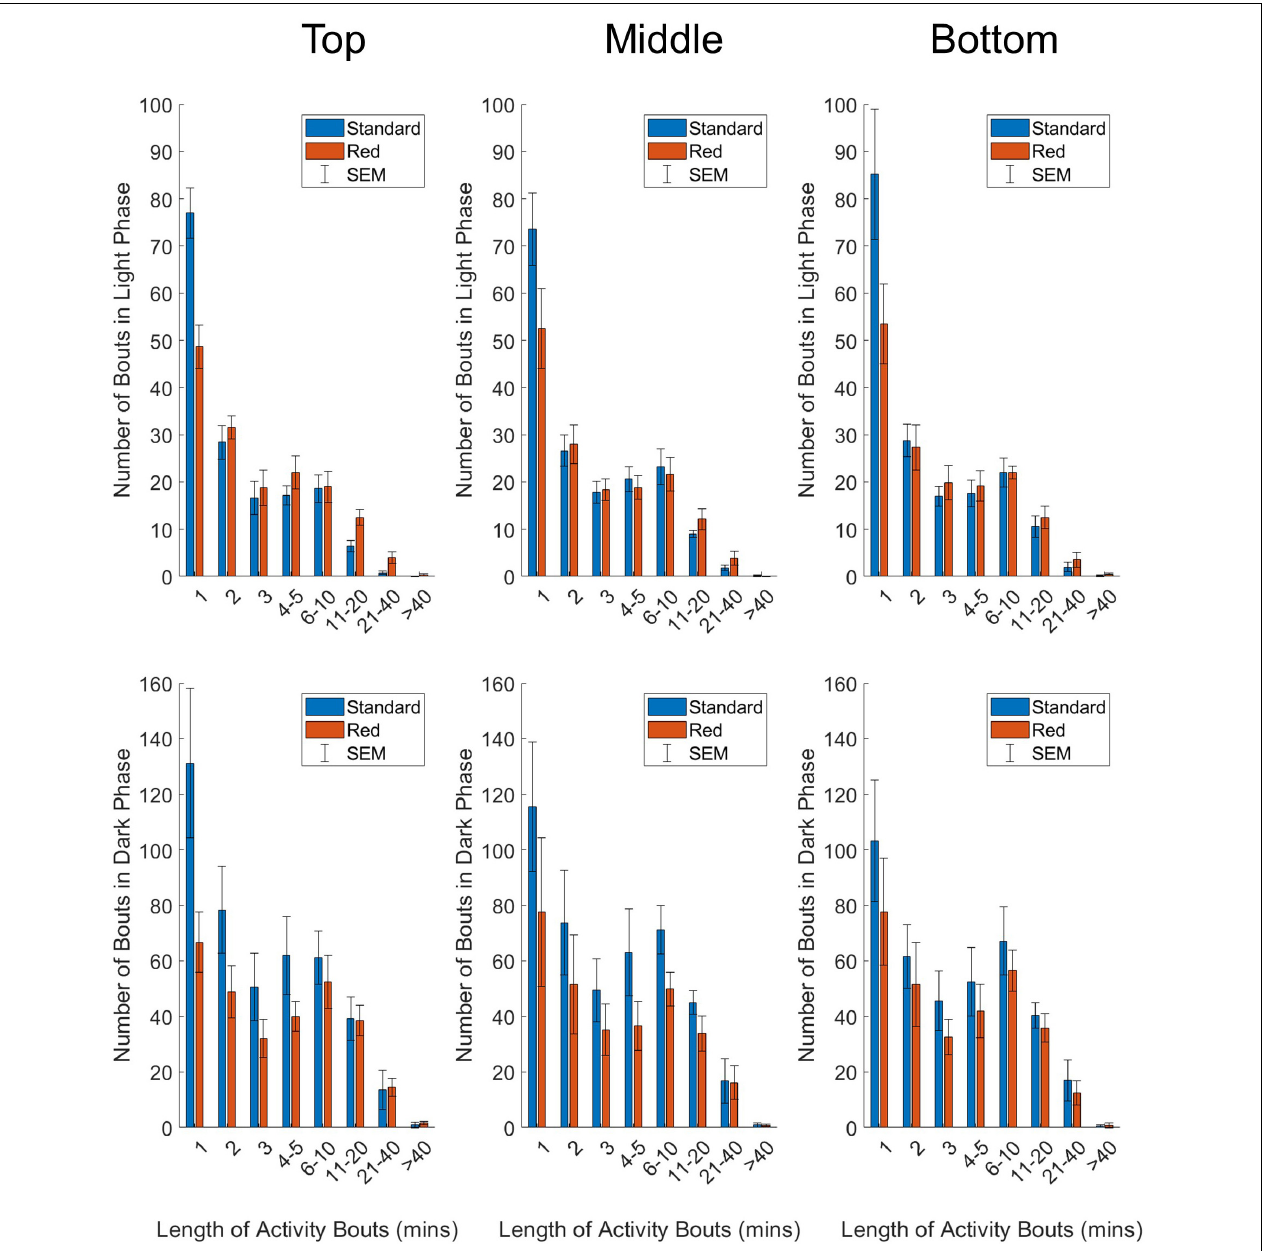
FIGURE 4 | Number of activity bouts of different lengths in standard (blue) and red (red) IVCs, plotted as mean +/– SEM in time-weighted frequency histograms. Analyzed separately for light phase (top panel) and dark phase (bottom panel) data, and separately by DVC rack position (top, middle, and bottom) . Two-way repeated-measures ANOVAs were used to test for significant effects of cage type and bout length on number of bouts. A significant main effect of bout length was reported for all positions, across the light and dark phase. A significant cage type by cage position was reported for all positions in the light phase, and the top position in the dark